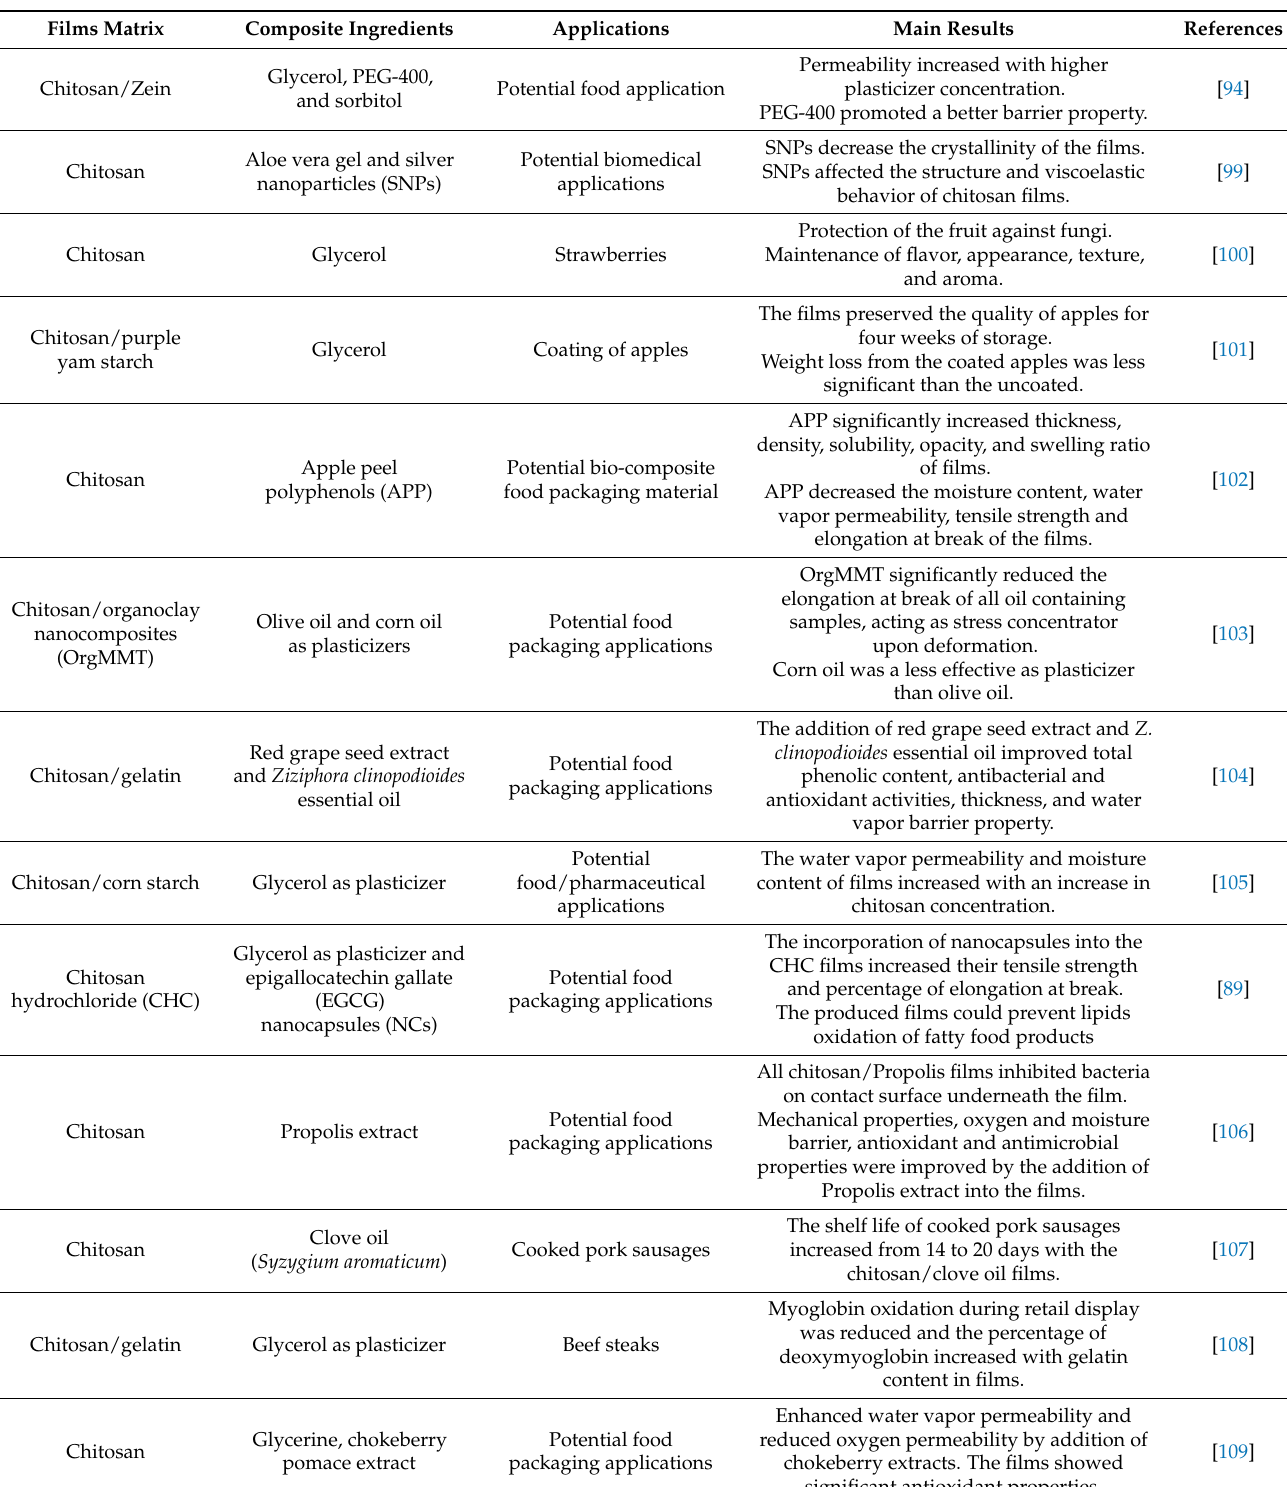
Table 2. Broad application of chitosan-based films and their main